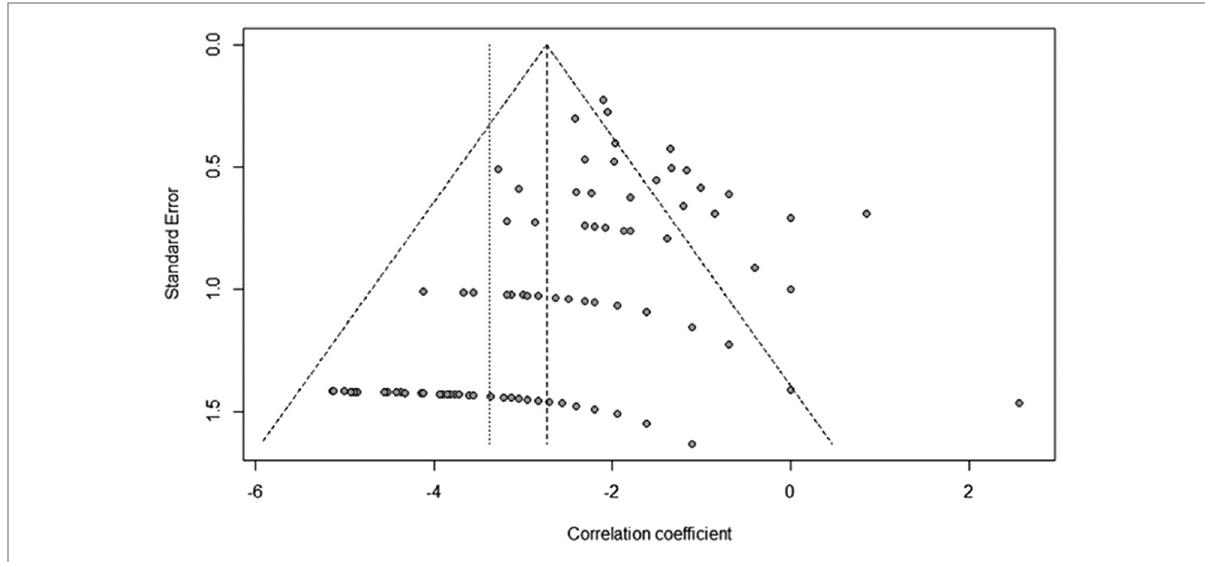
FIGURE 2 Publication bias: the asymmetric funnel plot makes a publication bias likely.